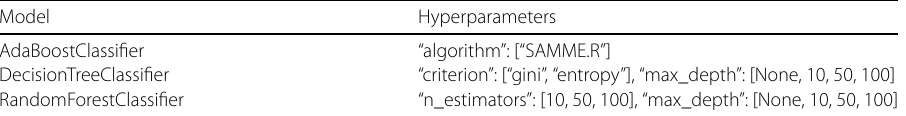
Table 18 Models and hyperparameters used for WHO-5 classification Model